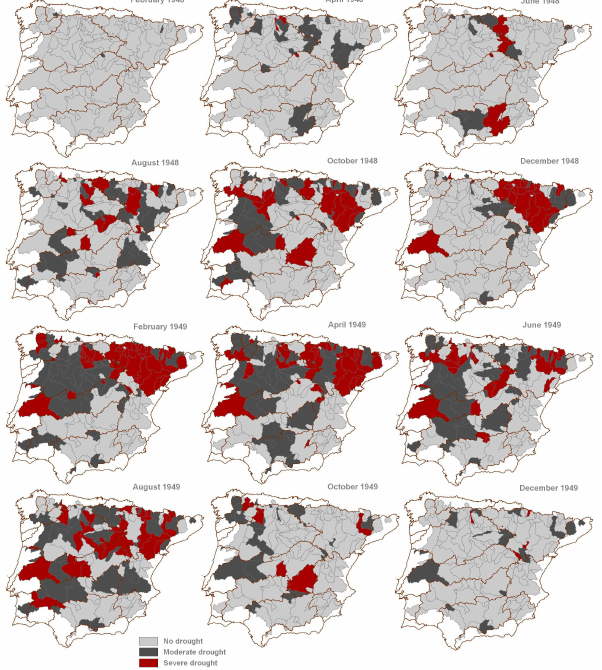
Fig. 8. Spatial coverage of the affected areas during the 1948–1949 drought. Dark grey depicted moderate drought conditions and red depicted severe drought conditions.